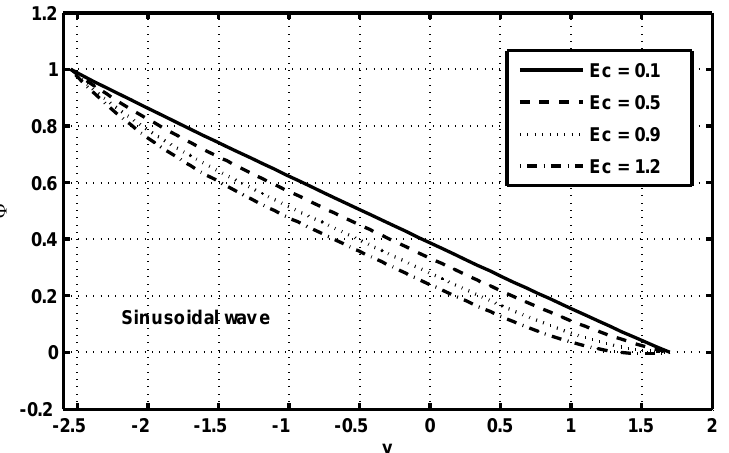
Figure 13. Concentration profile for di ff erent values of Ec for fixed a = 0.5, b = 1.2, d = 1.5, ϕ = π γ = 0.0009, η = 0.009, η = 0.001, k = 0.2, λ 1 2 Sr = 0.4, x =